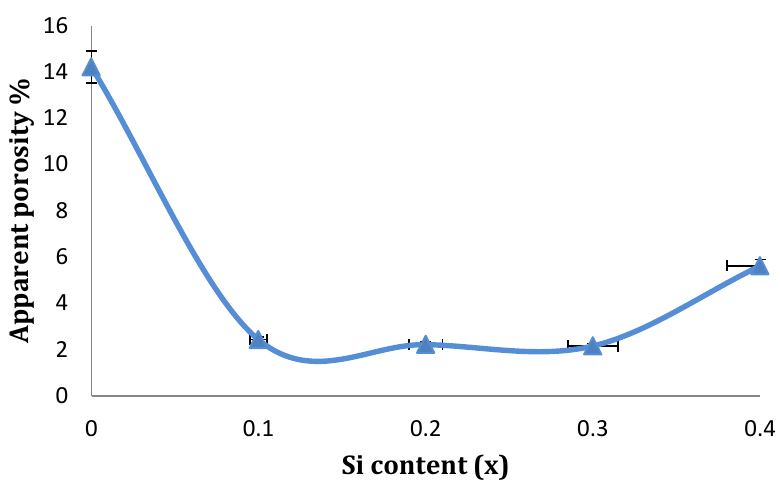
Fig. 4: The apparent porosity of (Mg